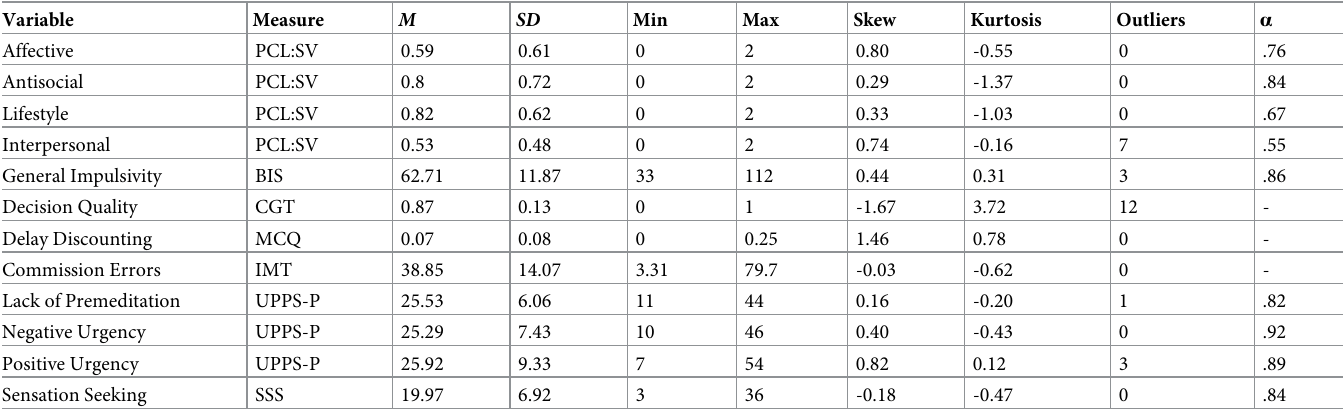
Table 1. Descriptive statistics of all study